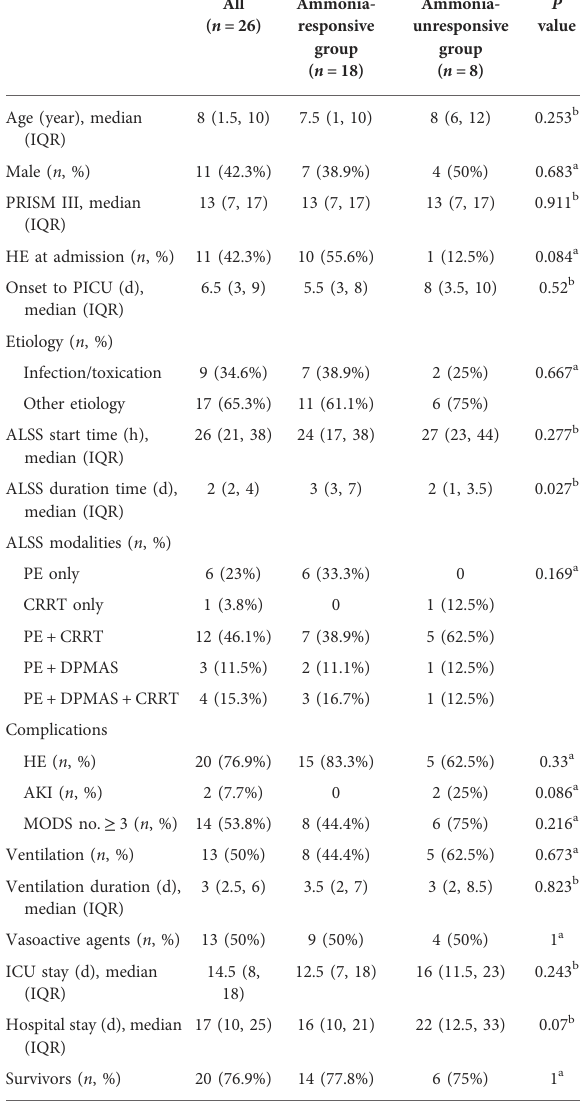
TABLE 3 Univariate analysis between the serum ammonia-responsive group and the unresponsive group.